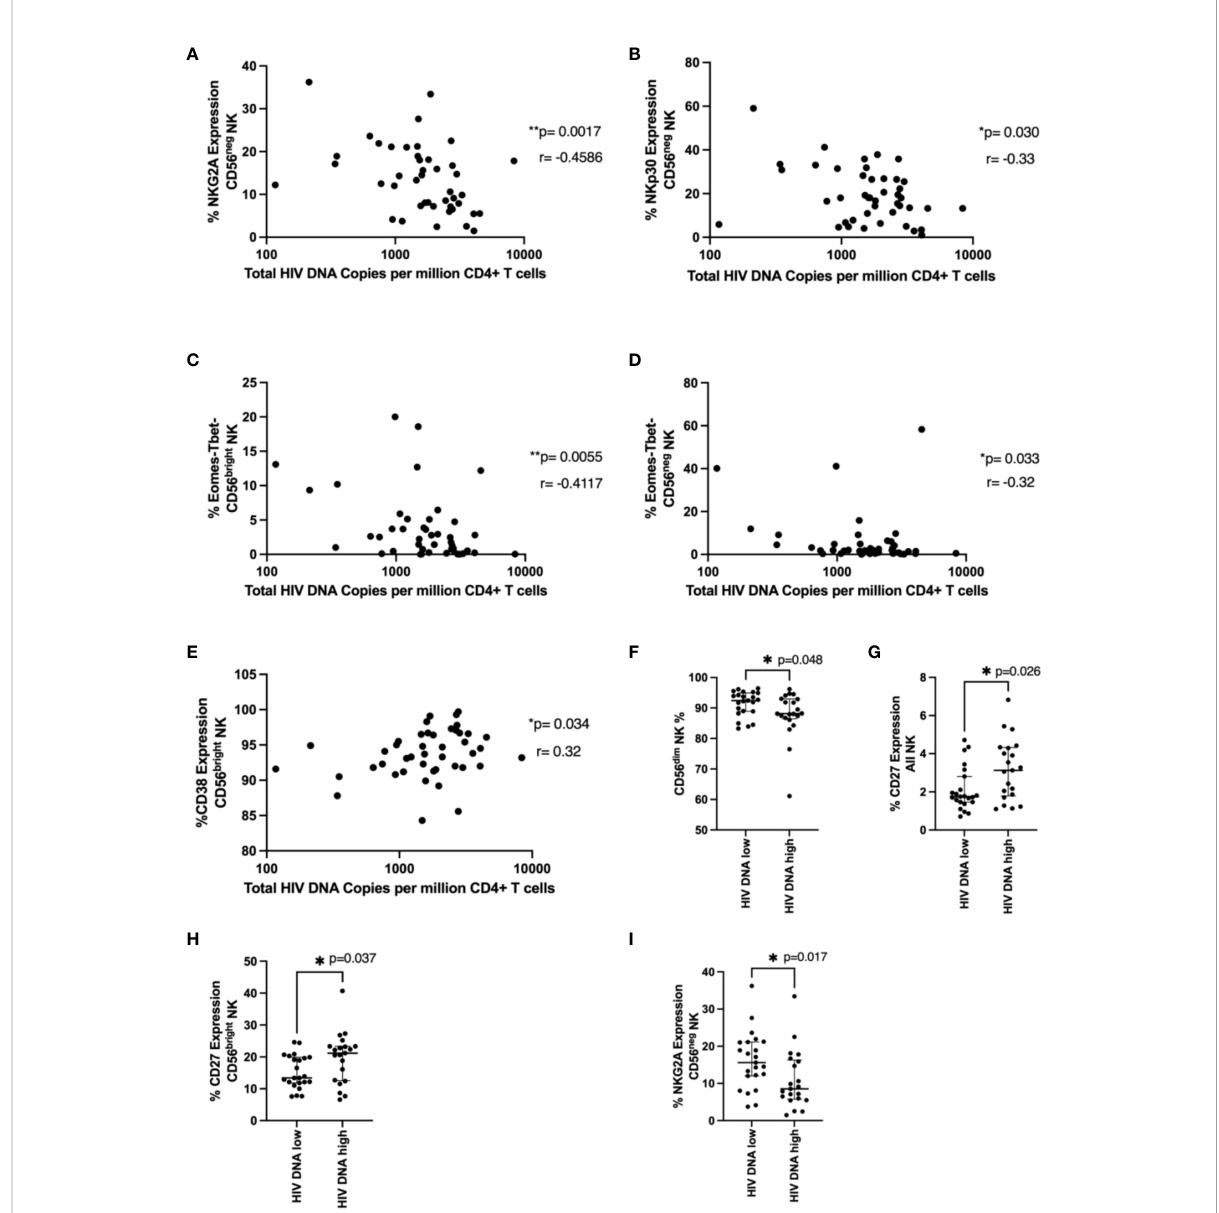
FIGURE 4 NK cell phenotype and HIV DNA levels. In (A – E) , total HIV DNA at 48 weeks (log scale) was correlated with the indicated NK cell marker in the indicated NK cell population using a Spearman correlation. p and r values are shown. In (F – I) , a Mann-Whitney test was performed between individuals with < or ≥ median HIV DNA levels (1749 HIV copies/million CD4 T cells) for the indicated marker and NK cell population. p values are shown. * represents p < 0.05, ** represents p < 0.01 (n =